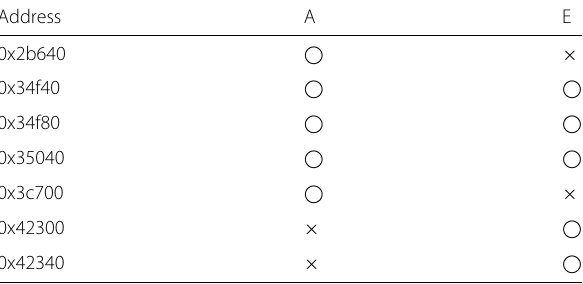
Table 2 Set of significant addresses from the profiles of the vowels a and